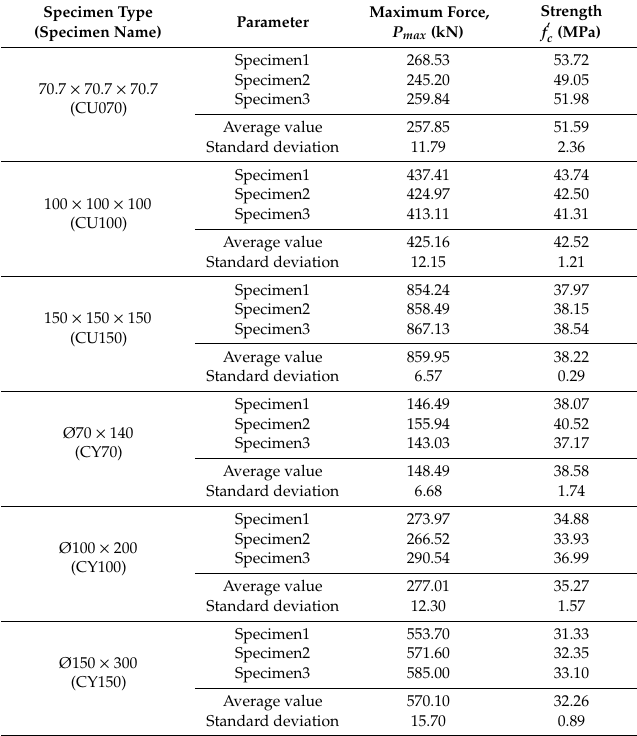
Table 7. Compressive resistances of the XT02 series at 28-day